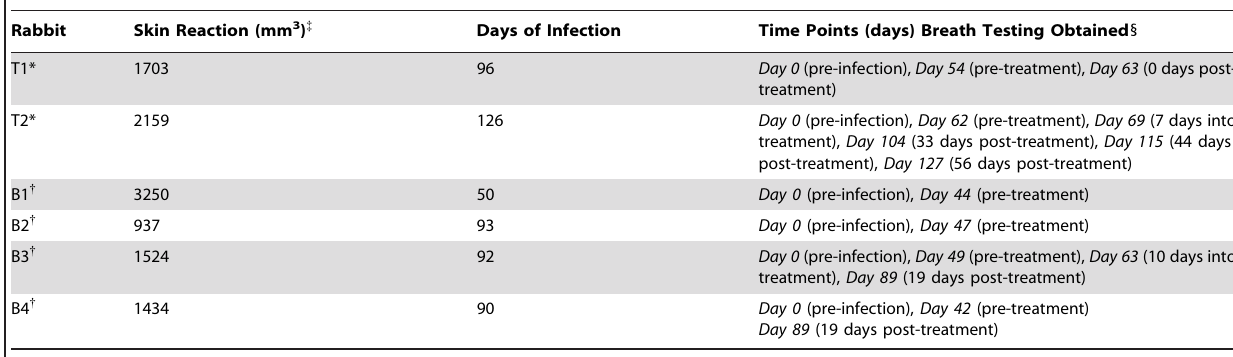
Table 1. Disease parameters associated with rabbit infection.